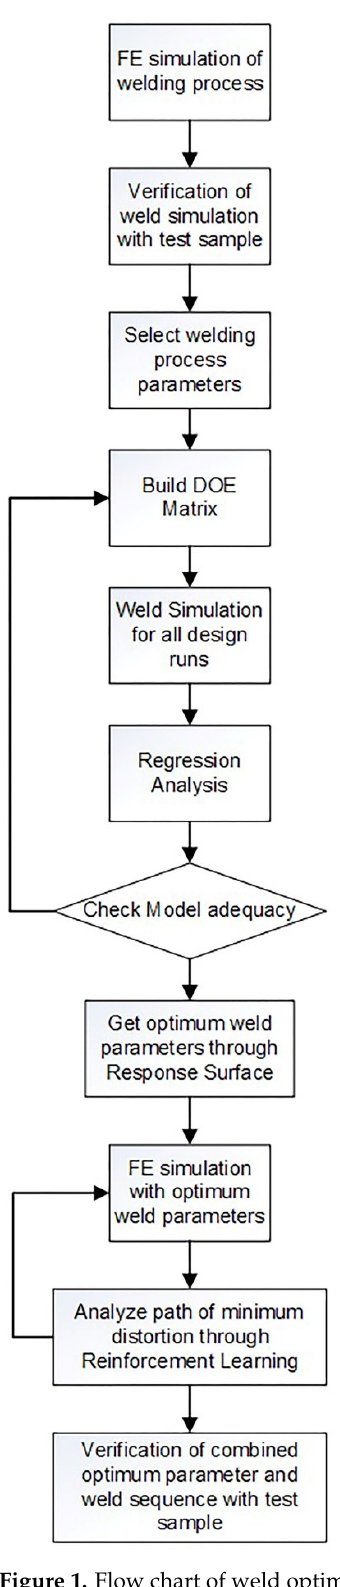
Figure 1 . Flow chart of weld optimization for distortion mitigation . Figure 1. Flow chart of weld optimization for distortion